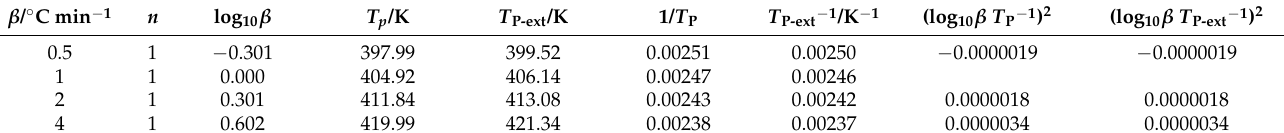
Table 5. Relevant parameters for BTBPC simulation analysis tests using the Ozawa method.